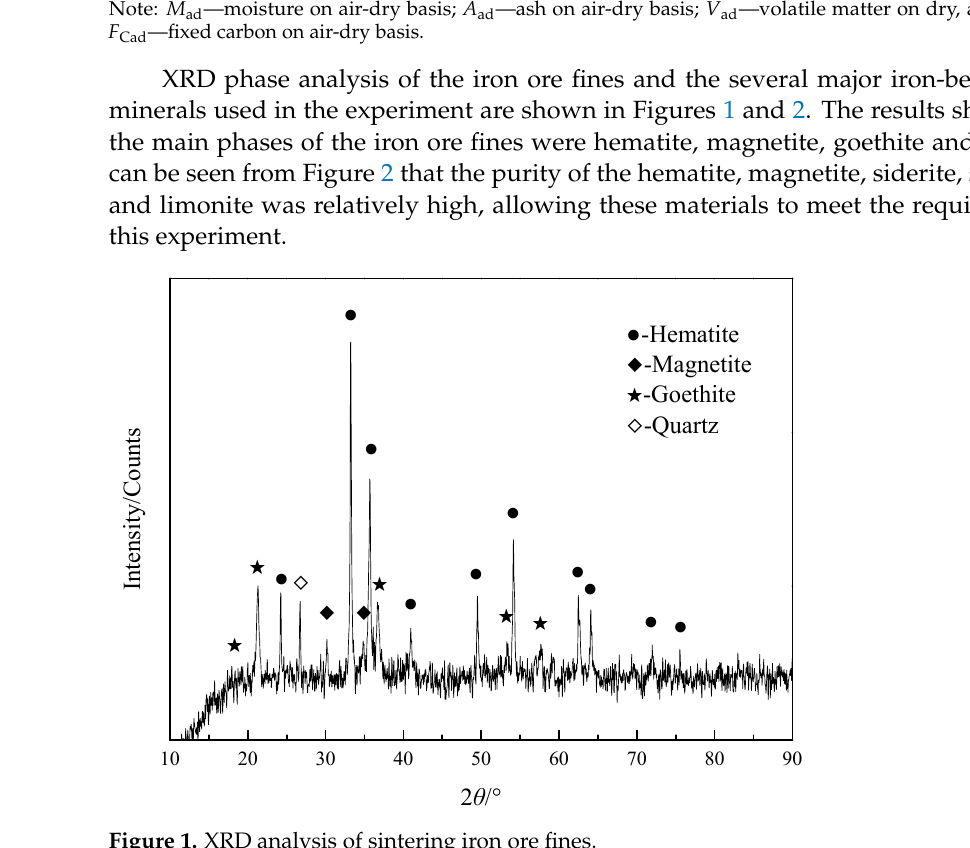
Table 2. Proximate and ultimate analyses of coal (air-dry basis)/wt.%.